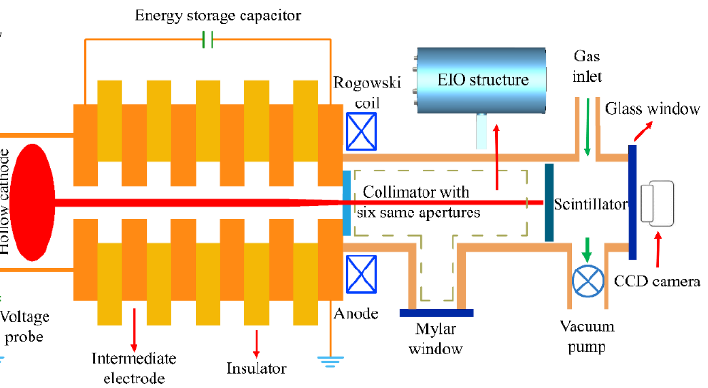
Figure 1. The schematic drawing of the five-gap PS electron beam discharge setup and multiple- beam EIO.